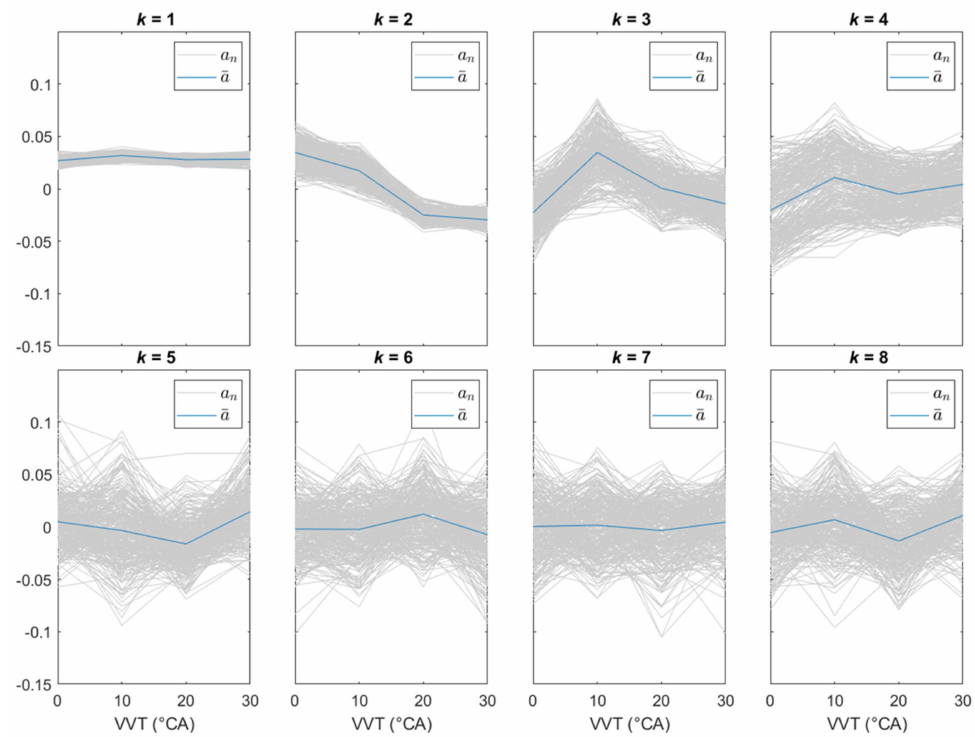
Figure 7. Evolution of the POD coefficients as a function of the VVT offset; POD: θ = 130 ◦ CA; θ VVT = { 0,10,20,30 } ; n : cycle number; k : mode